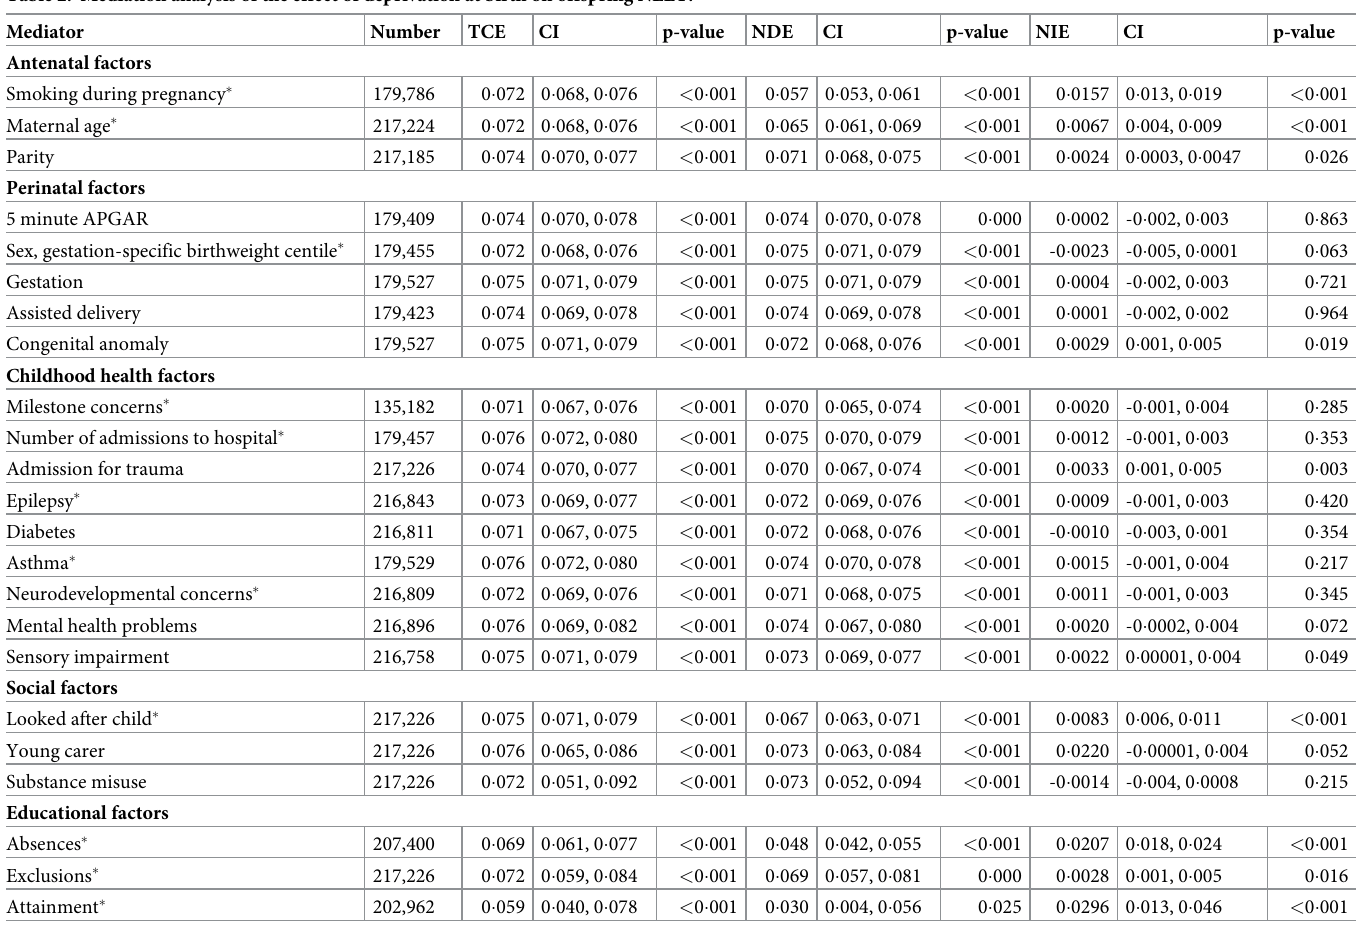
Table 2. Mediation analysis of the effect of deprivation at birth on offspring